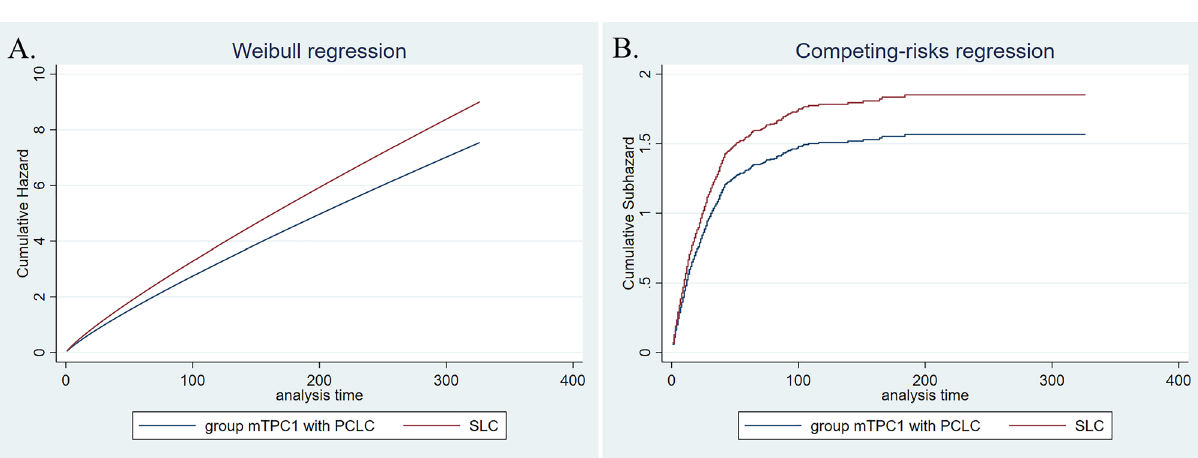
Figure 3. Adjusted cumulative hazard of all-cause death ( A ) and cancer-specific death ( B ) in mTPC1 group with PCLC and matched single lung